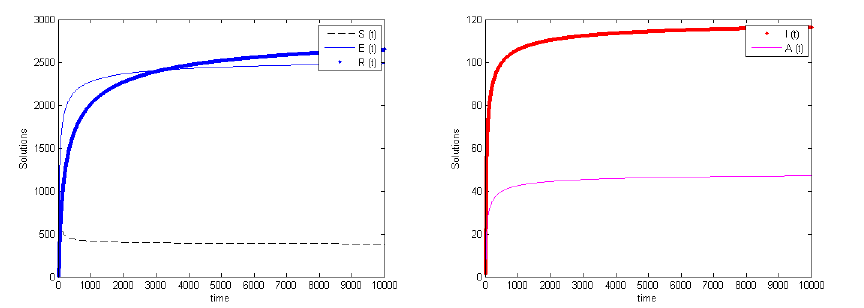
Figure 2. The model behavior for R 0 = 1.1421 > 1. ( Left ) exposed and recovered settle at a level near 2500, susceptibles drop to about 500; ( Right ) infected stabilize at 120 individuals, asymptomatic instead at 40 individuals. This corresponds to the endemic equilibrium P ∗ . The parameter values are Λ = 500, β = 0.01, k = 0.1, d p = 0.082, α = 0.15, ω p = 0.1, ω (cid:48) I γ (cid:48) p = 0.6024, ν =